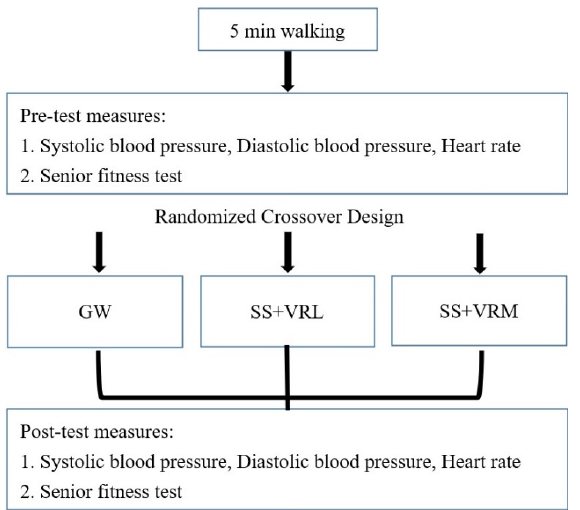
Figure 1. The experimental design of the study.